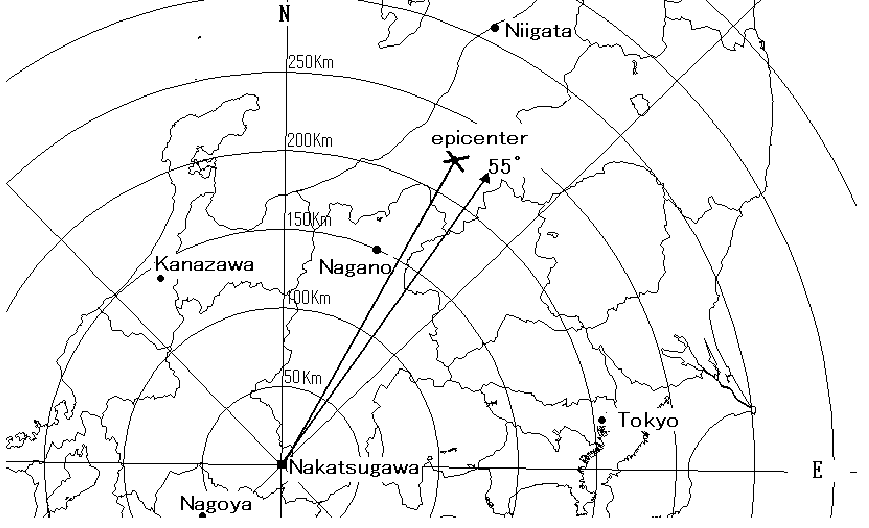
Figure 10. Goniometric direction of ULF noises during 2-6 October as seen from Nakatsugawa. The epicenter is also indicated, for the sake of comparison.